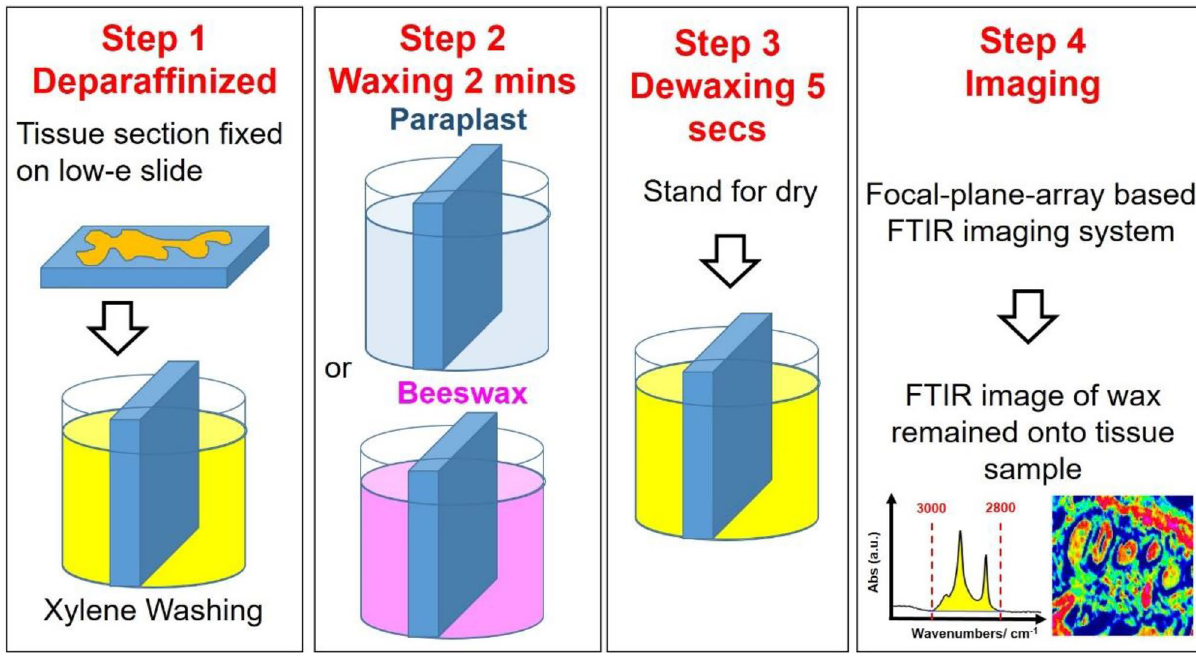
Figure 1. Process of WPK of wax residual imaging for NENs detected by